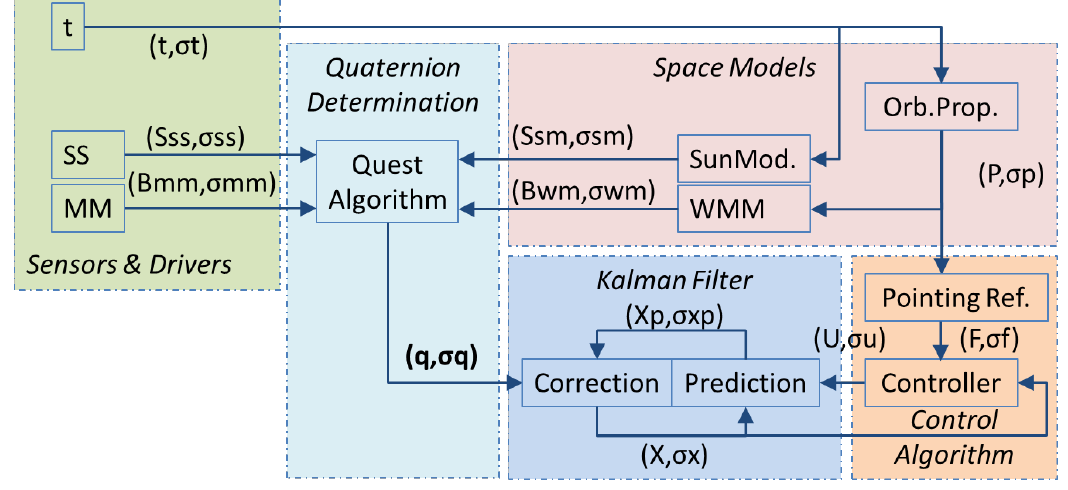
Figure 1. Attitude determination block diagram.